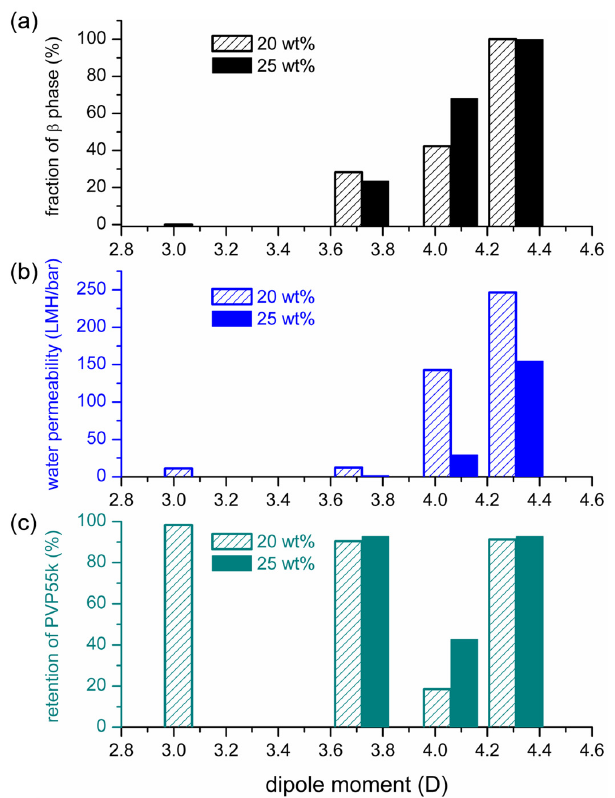
Figure 8. Dependence of the fractions of β -crystalline phase ( a ), water permeabilities ( b ) and retention of PVP ( c ) of PVDF membranes on the dipole moments of the solvents used to dissolve PVDF.